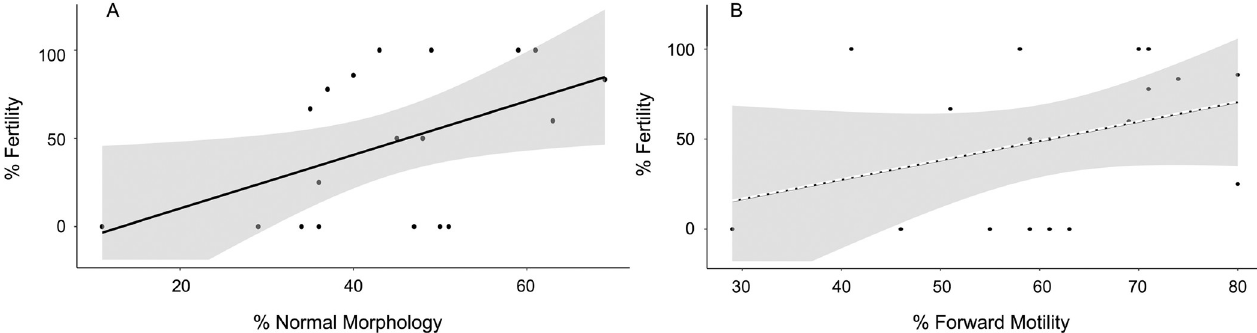
Fig 2. Scatterplots of the linear relationship between A) percent sperm with normal morphology and percent fertility (r 2 = 0.24, P = 0.03) and B) percent sperm with forward motility (r 2 = 0.12, P = 0.16) of semen from 20 adult male Louisiana pinesnakes. Solid line represents a significant regression line at the 0.05 level, while a dashed line represents a non-significant regression line and shading shows the 95% CI.